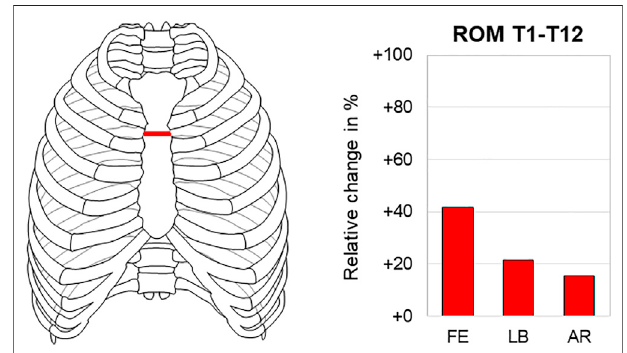
FIGURE 6 | Transverse sternal fracture. The relative range of motion (ROM) changes in the thoracic spine (T1 – T12) during fl exion/extension (FE), lateral bending (LB), and axial rotation (AR) after transverse sternal fracture according to Watkins et al. (2005).